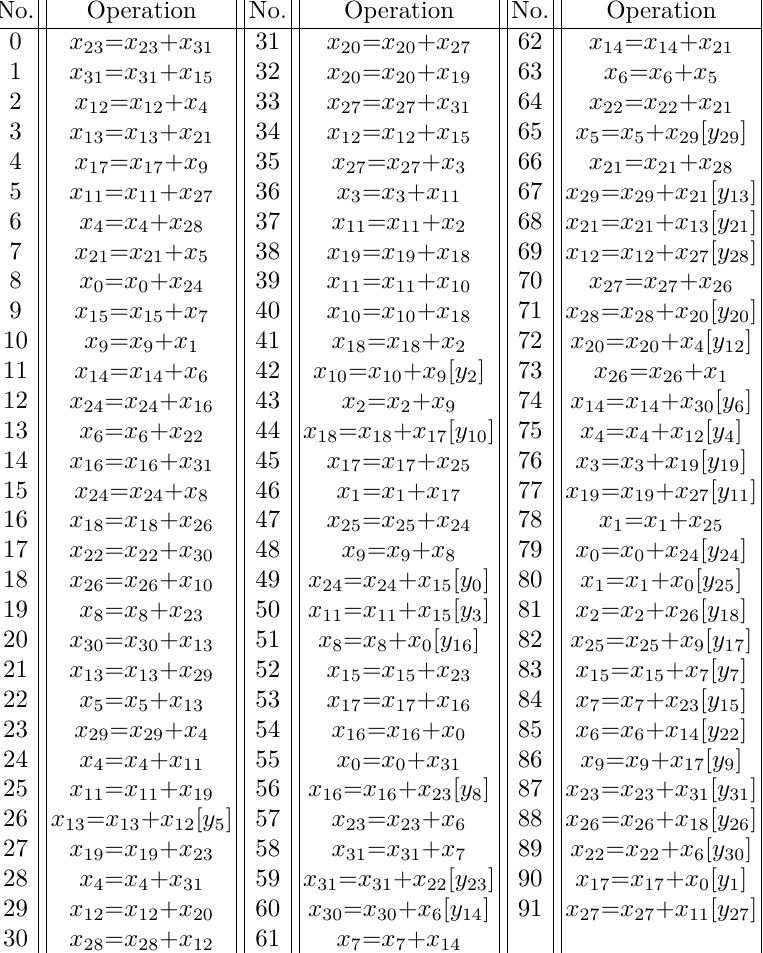
Table 3: An implementation of AES MixColumns with 92 Xor